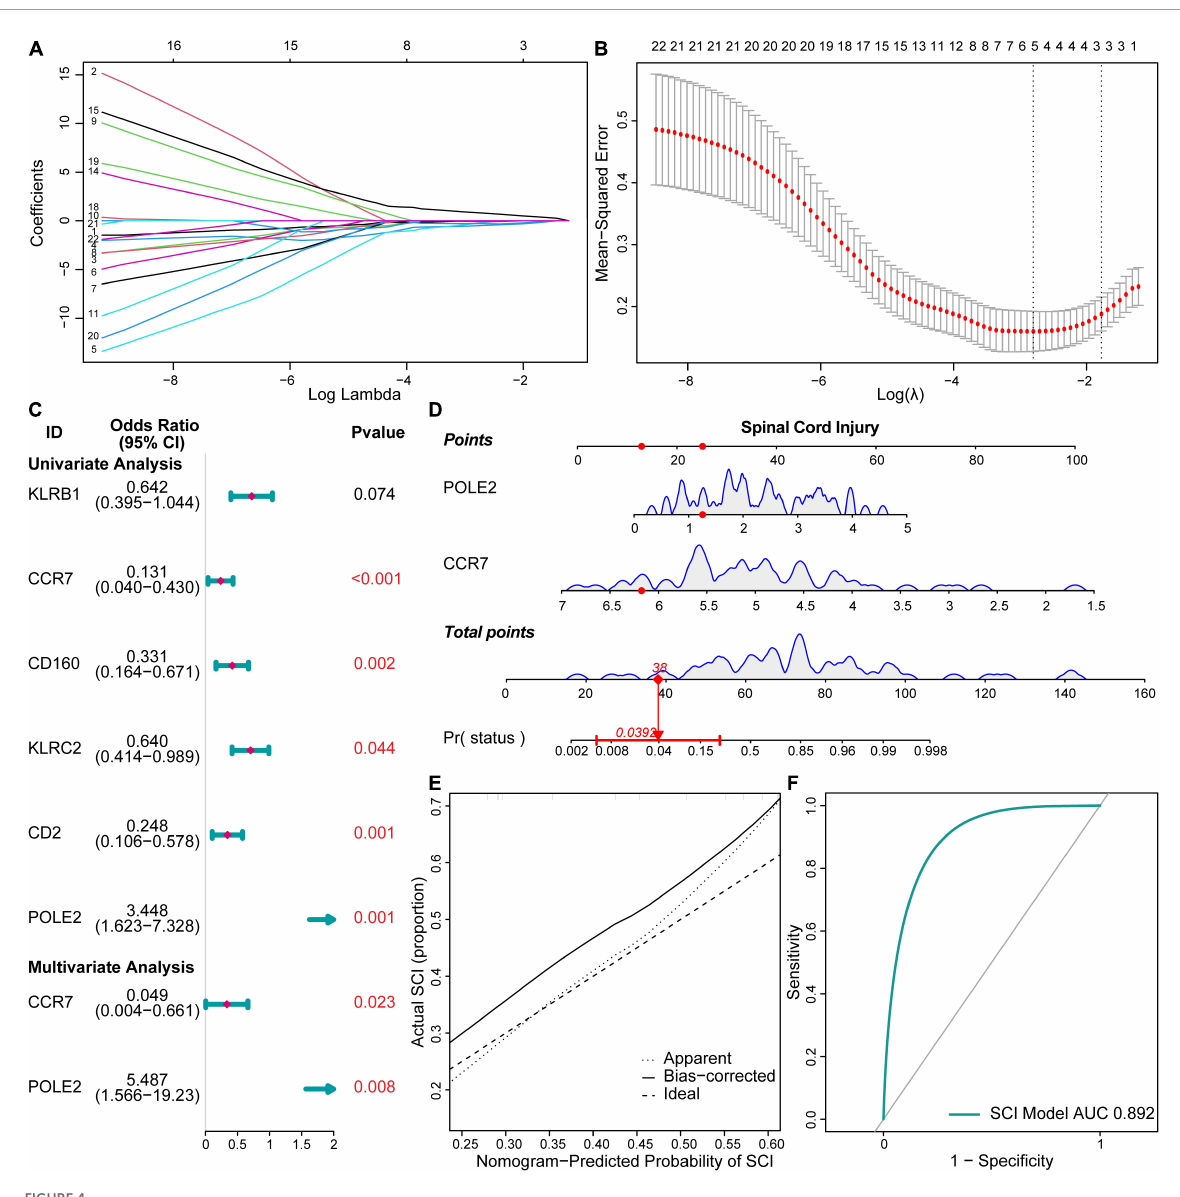
FIGURE4 Risk models and clinical prediction models for acute SCI. (A,B) Least absolute shrinkage and selection operator regression identified key genes in acute SCI. (C) Forest plot for logistic regression. (D) Nomogram prediction model. (E) Calibration curve for the nomogram prediction model. (F) Receiver operating characteristic (ROC) curve of the nomogram prediction